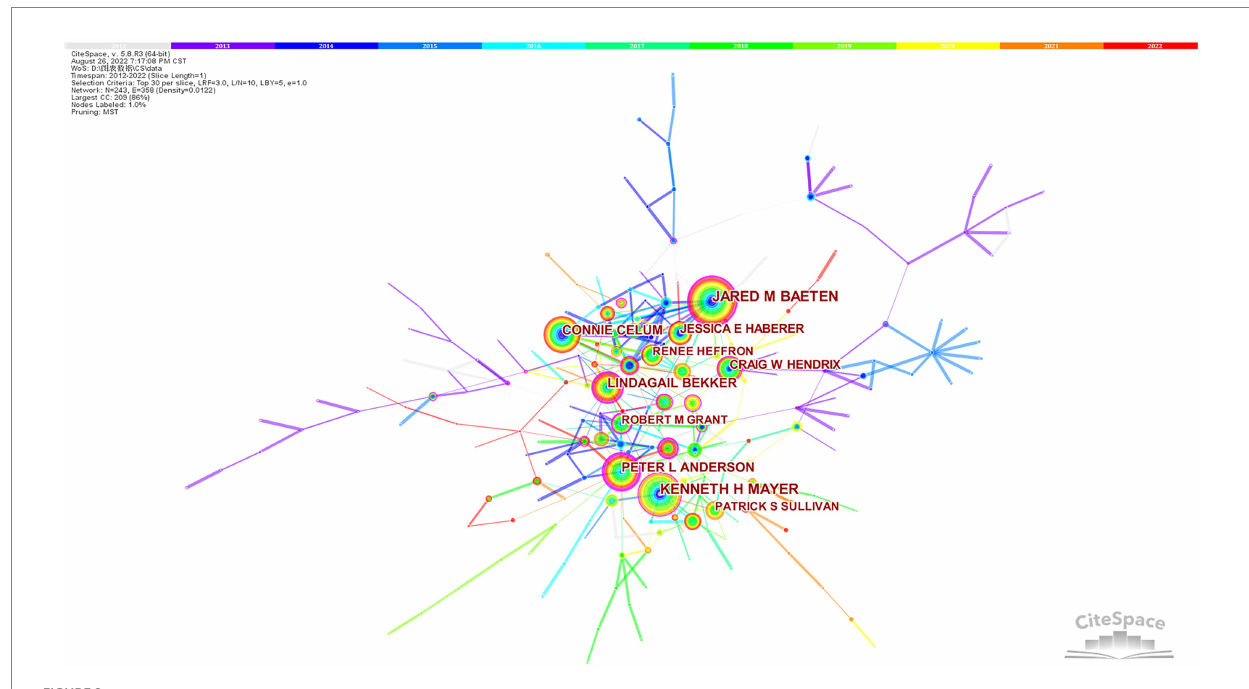
FIGURE 2 The network of coauthors.